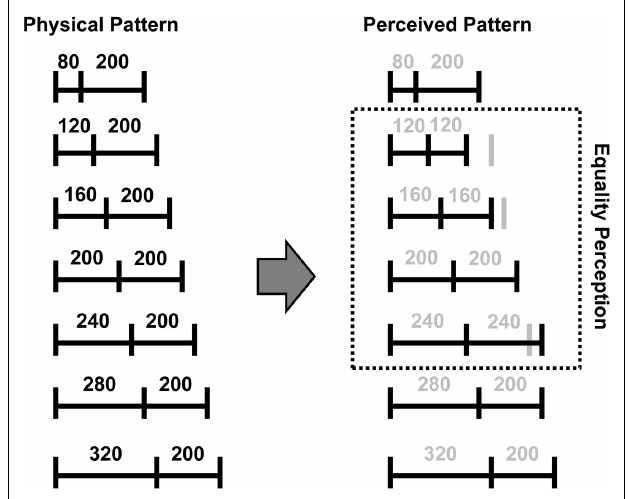
FIGURE 1 |A schematic description of the equality perceptions of the temporal patterns used in the present study. Horizontal lines represent empty time intervals.Vertical lines represent tone bursts. Numbers indicate durations in